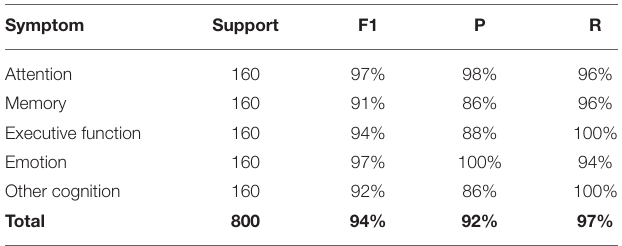
TABLE 1B | Performance of the NLP-CI tool for individual domains (separate blind set). Symptom